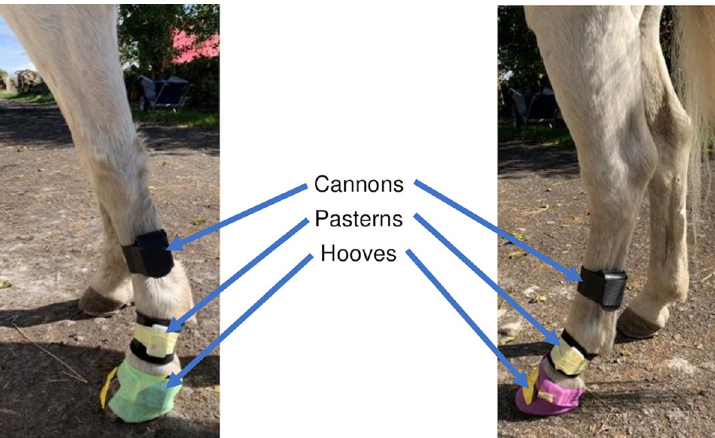
Fig 1. IMU placement. Sensors were attached to the cannons, pasterns and hooves of the left fore- and hindlimbs using custom-made pockets, Velcro wraps and elasticated bandages, respectively, and secured with